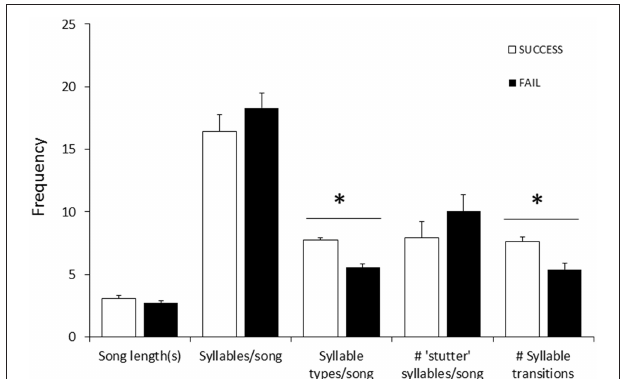
FIGURE 6 | Differences in female song measures (song length, number of syllables, number of syllable types, number of transitions between syllable types, and number of “stutter” syllables; averaged using three songs per female) between nests that successfully fledged chicks ( (cid:3) , n = 10) and nests where eggs hatched but no chicks fledged ( (cid:4) , n = 9). Data included nests from 2013/14 ( n = 9) and 2014/15 ( n = 10), all by different females. There was no difference between years in the proportion of successful or failed nests (2013: 5 successful, 4 failed; 2014: 4 successful, 5 failed). Significant differences (Mann-Whitney U-test) are indicated ( * ).